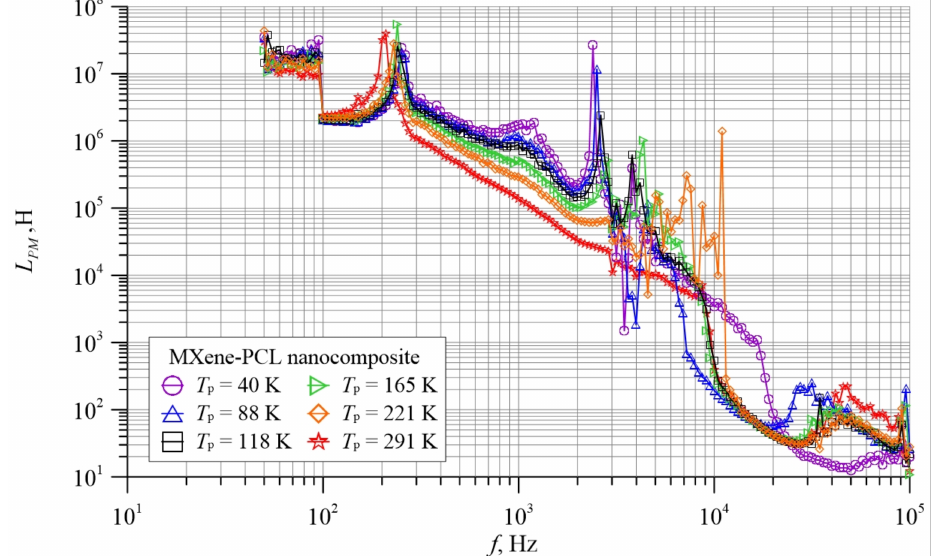
Figure 8. Frequency dependence of inductance L PM of the MXene-PCL nanocomposite for six selected temperatures measured in a parallel substitution